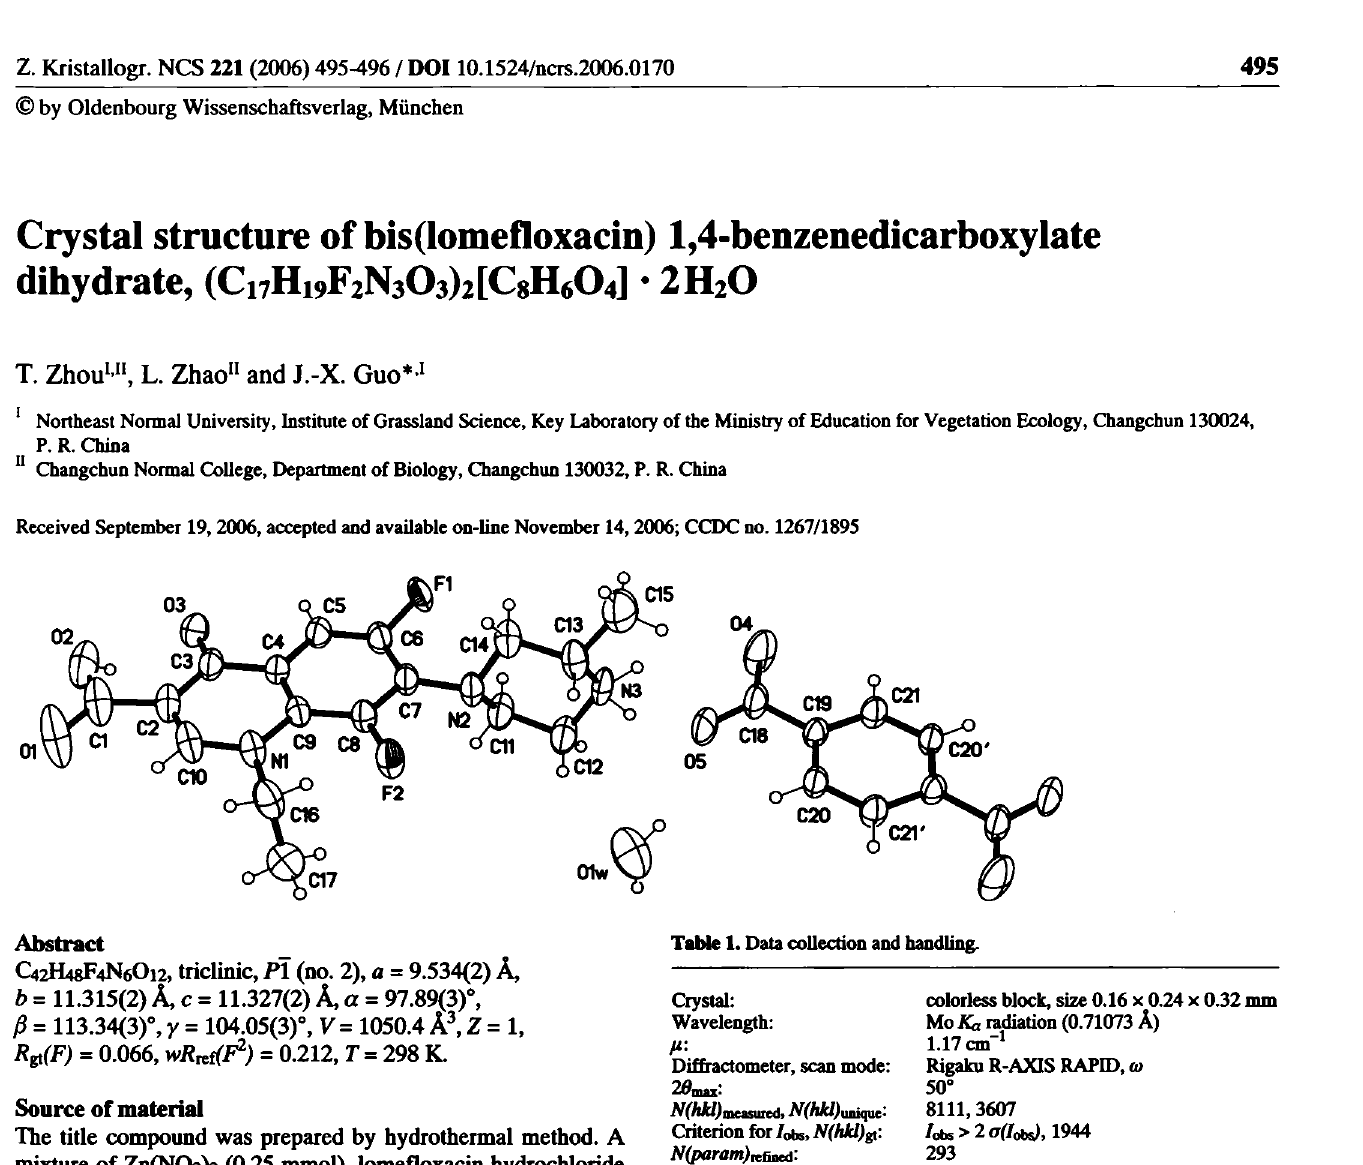
Table 2. Atomic coordinates and displacement parameters (in Ä 2